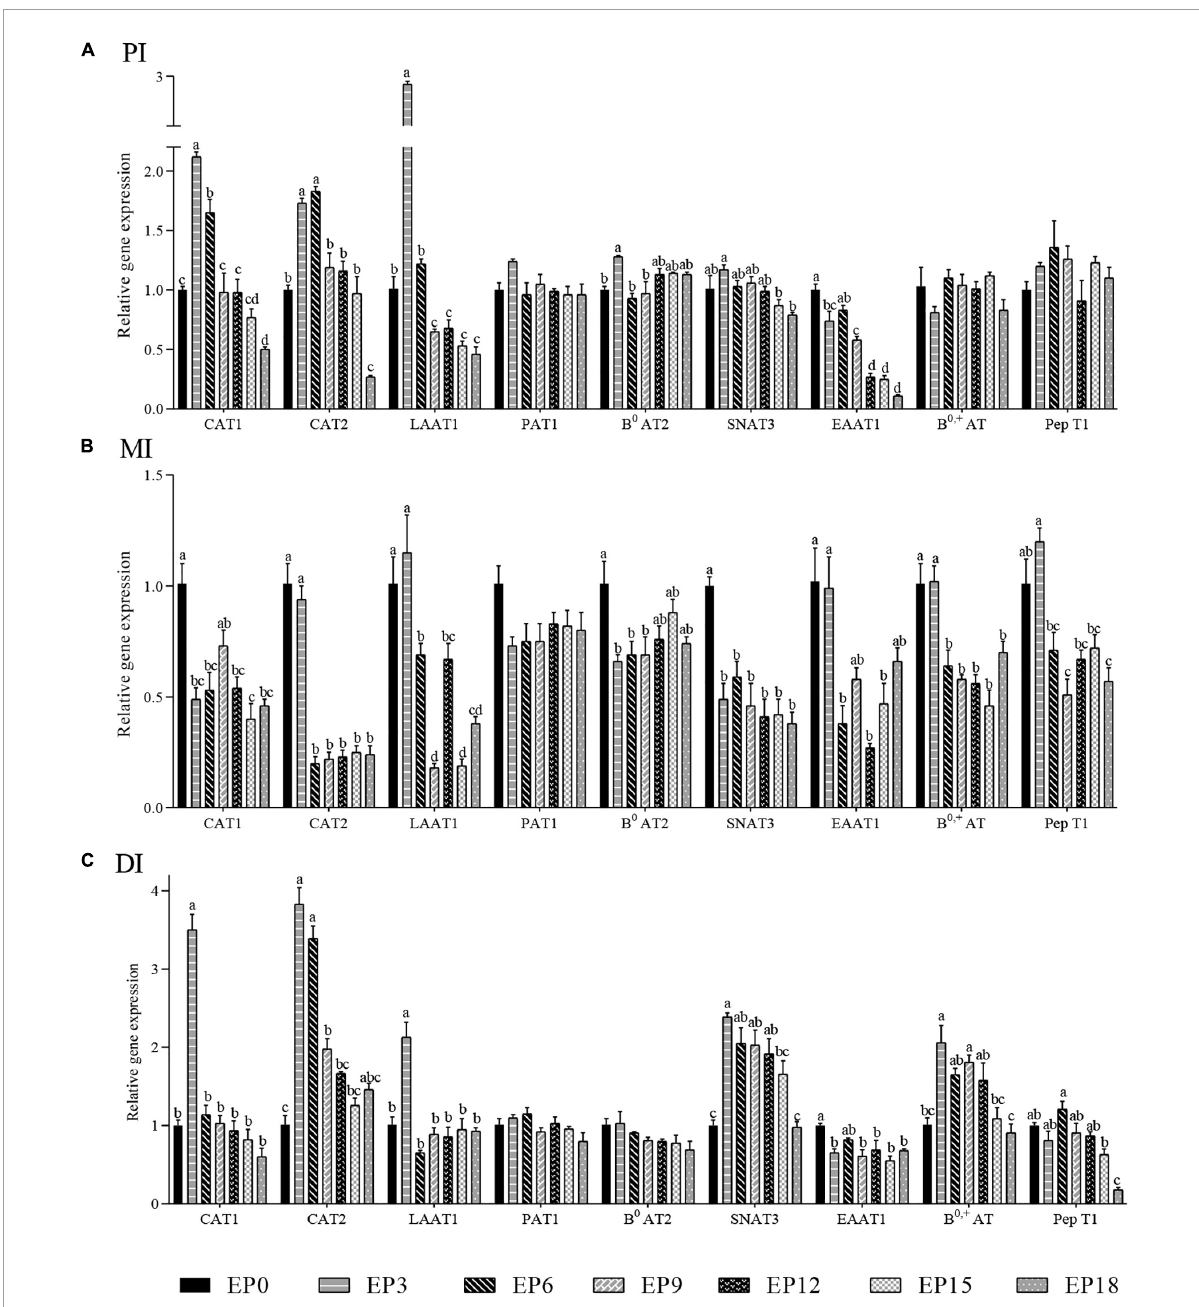
FIGURE8 Relative mRNA expression of amino acid and small peptide-related transport in the (A) proximal intestine (PI), (B) mid-intestine (MI), and (C) distal intestine (DI) of hybrid groupers fed with diets, respectively. The β -actin gene was used as a housekeeping gene, and the control group was used as the reference group. Columns represented the mean values ± S. E. M. of each group. Different letters in each figure indicate significant differences among groups (a > b > c > d; P < 0.05).